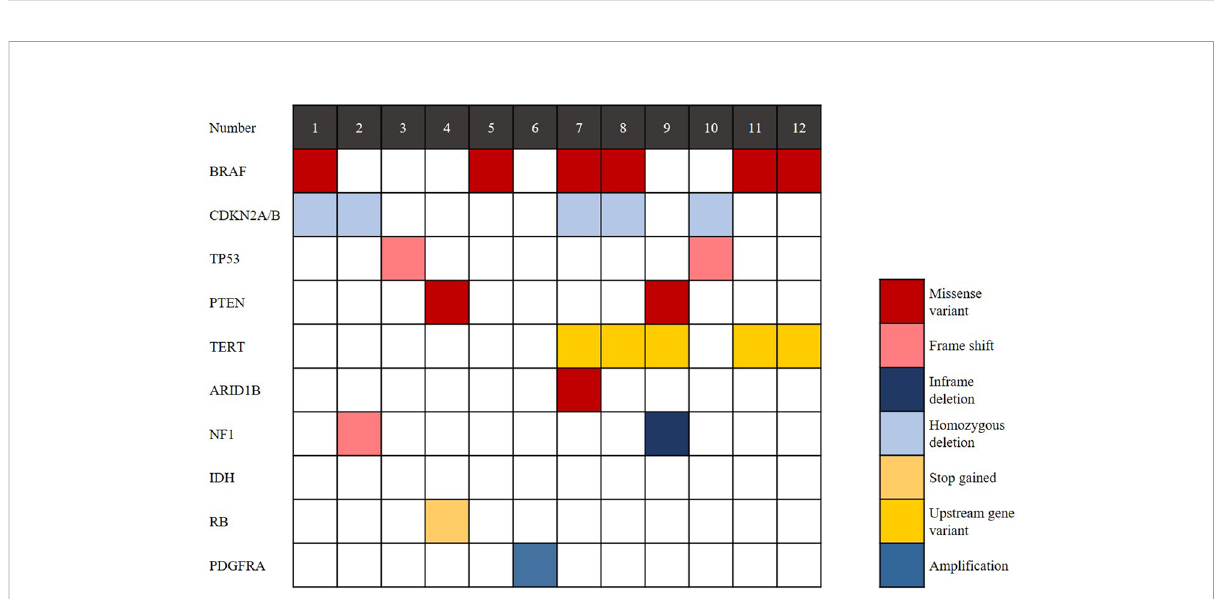
FIGURE 4 Genomic landscape of eGBM. Clinical and genomic features of 12 eGBM cases. In addition to BRAF V600E mutation, eGBM also showed TP53 mutation, CDKN2A/B homozygous deletions and NF1